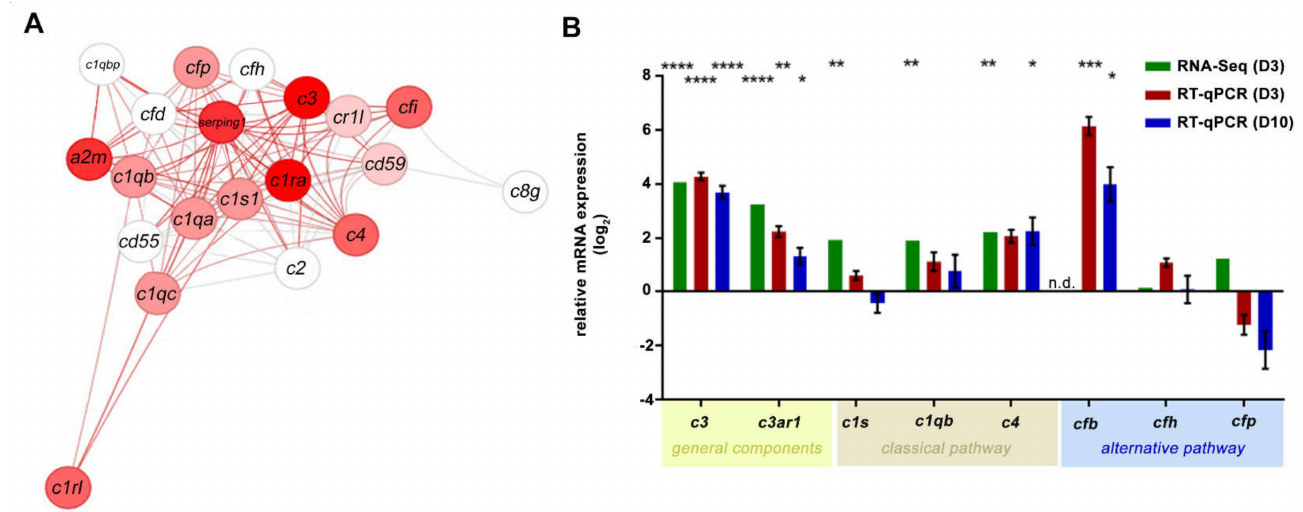
Figure 2. Increase in the mRNA expression of the complement components in the retina following NaIO 3 treatment. ( A ) The transcript quantity of the components of the complement pathway (GO: 0006956) was changed in the retinas after the NaIO 3 treatment at day 3. Nodes are the genes with their connections as defined in STRING database version 10, and the colour is given by the fold change (log2FC = 4) of the regulation (red = up, white = no regulation). ( B ) The fold change (log 2 ) mRNA expression levels of the general ( c3 and c3ar1 ), classical ( c1s and c4 ) and alternative ( cfb ) pathway components were analysed in independent experiments using either RNA-seq or RT-qPCR. The retinal tissue was harvested at day 3 (RNA-seq analysis, n = 5) or day 3 and day 10 (RT-qPCR, n = 6) after NaIO 3 application. RNA-seq gene expression was normalised to the overall gene set. The RT-qPCR expression was normalised to the idh3b reference mRNA. Fold change in the expression (compared to the untreated control, line at y = 0) was calculated on the logarithm to base 2. The gene expressions of treated versus untreated retinas were evaluated using ordinary one-way ANOVA and Tukey’s multiple comparisons test (* 0.01 < p < 0.05, ** 0.001 < p < 0.01, *** 0.0001 < p < 0.001 and **** p <